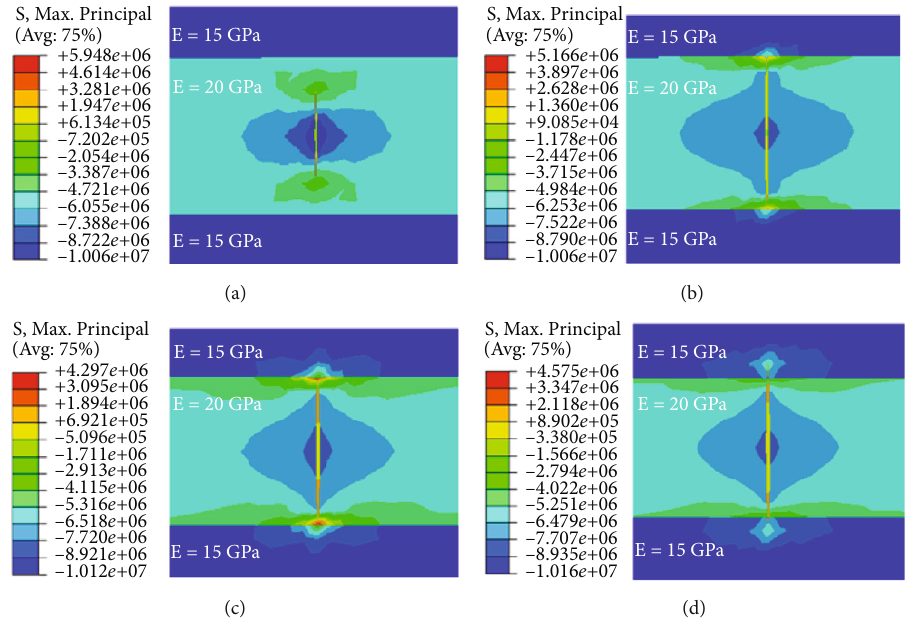
Figure 19: E ff ect of temperature on the development of hydraulic fracturing height for a range of temperature from 100 ( ° C) to 250 ( ° C) along with the depth of the layers and at di ff erent times: (a) 10 steps, (b) 20 steps, (c) 40 steps, and (d) 50